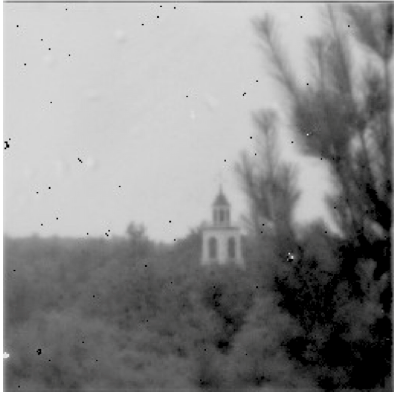
Figure 14. Image of church steeple.